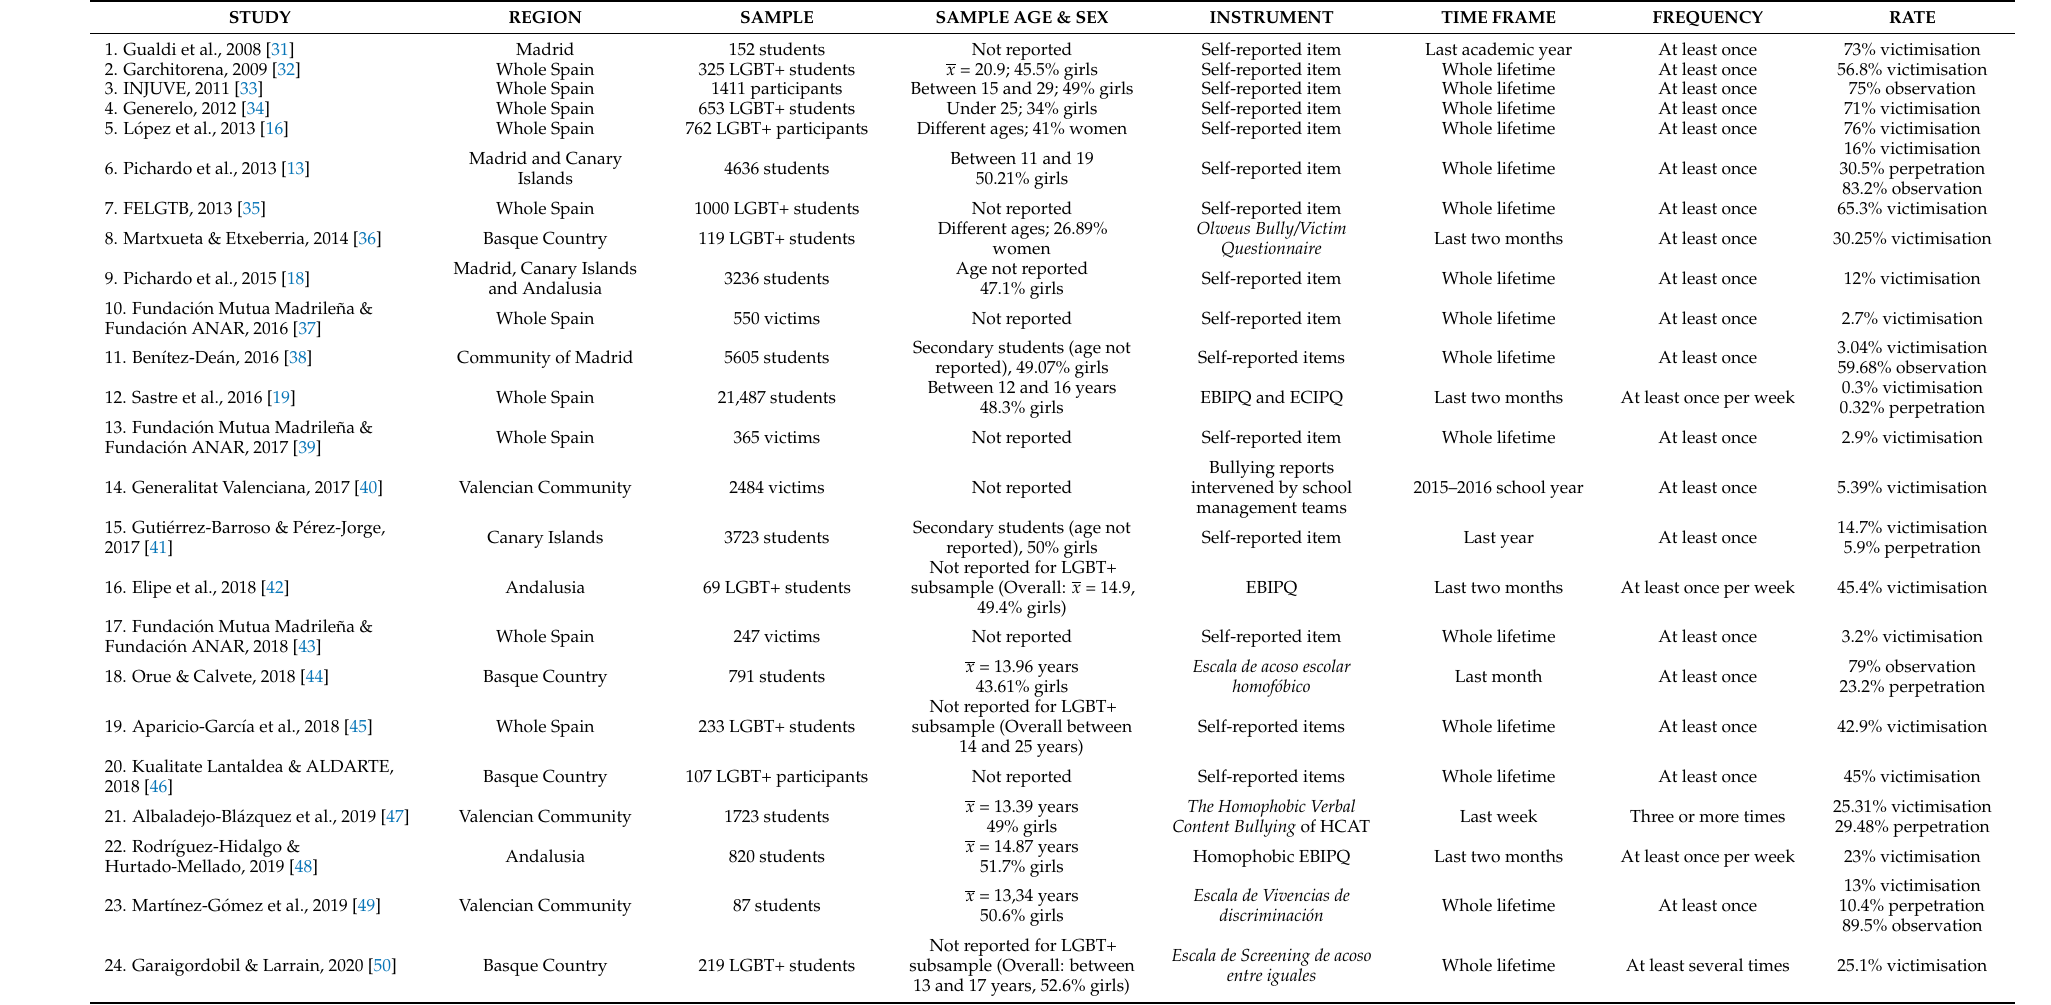
Table 1. Characteristics of the studies selected for inclusion in the